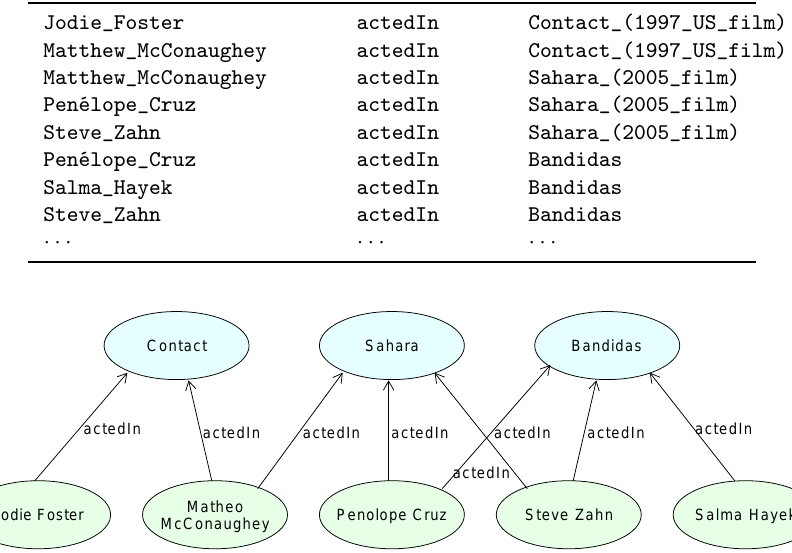
Figure 1. Sample RDF Graph of yago:actedIn predicate in YAGO.